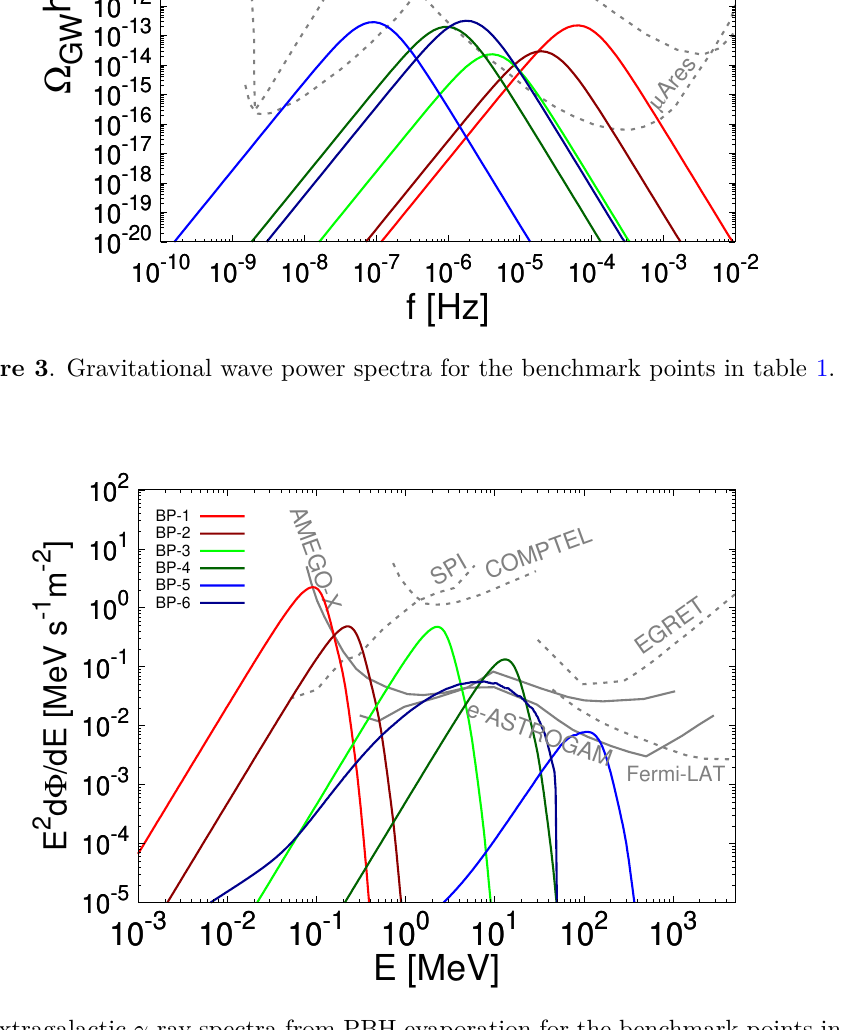
e-ASTROGAM telescopes. The 3 σ sensitivities, including those of the past and current telescopes, SPI, COMPTEL, EGRET, and Fermi-LAT are shown. The spectral shape of BP-6 is different from that of the other points because in the instantaneous photon spectrum in figure 1, the sharp peak expected from Hawking emission is washed out by secondary emission. Note that only BP-1 has Ω h 2 ∼ Ω h 2 , and that the relic density PBH DM of BP-6 is vanishingly small because the PBHs have a much shorter lifetime ( ∼ 10 7 yr) than the age of the